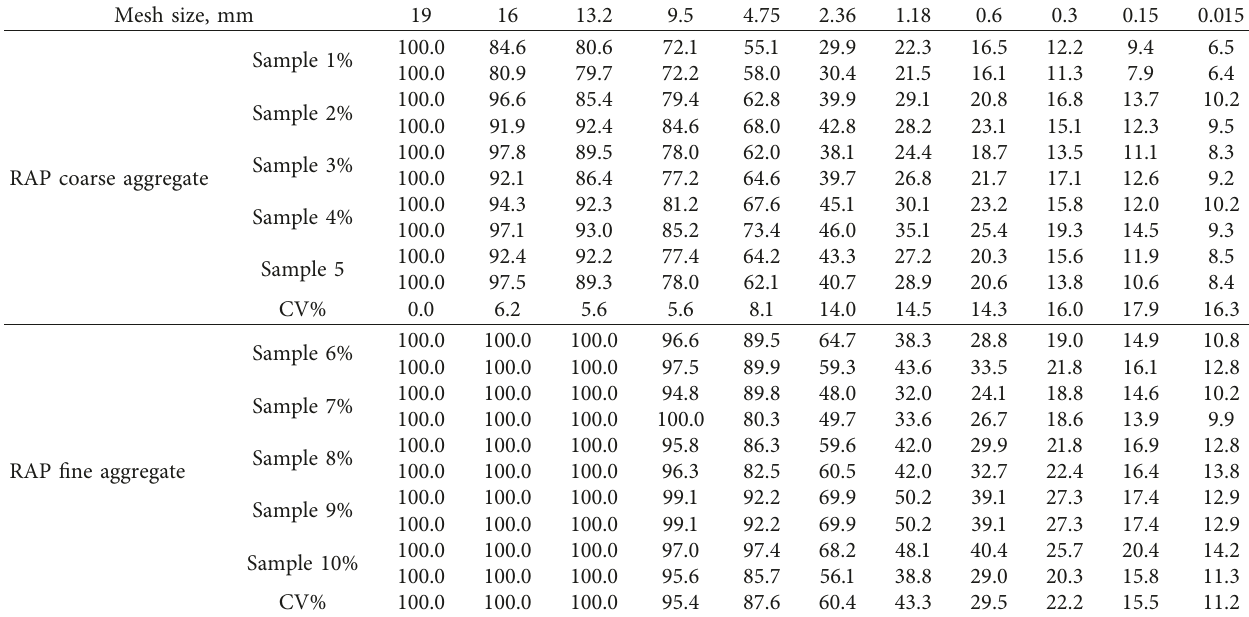
Table 2: Gradation and coefficient of variation of RAP.